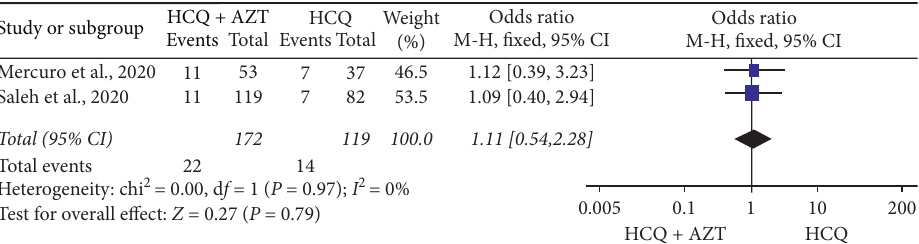
Figure 7: Risk of QT prolongation among COVID-19 treated with HCQ+AZ versus